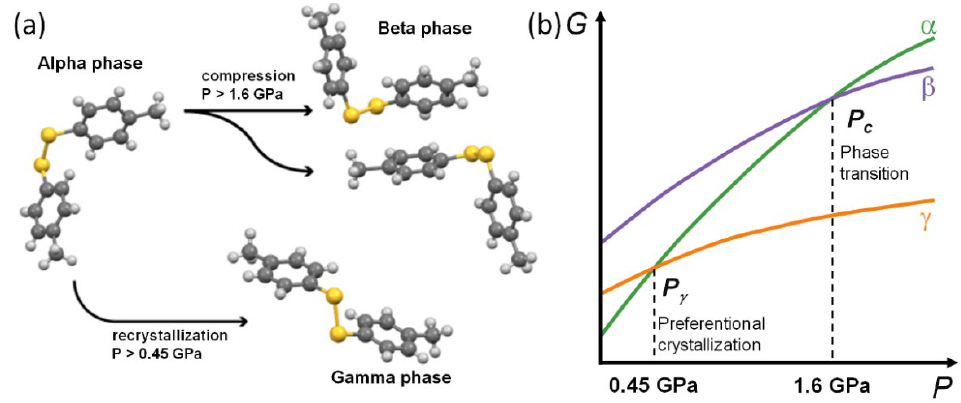
Figure 1. ( a ) Principal scheme of the experimentally observed phase transitions in a di- p -tolyl disulfide system. The α → β phase transition is given by two arrows due to formation of two different molecular conformations. ( b ) Suggested relations between the free Gibbs energy of phases α, β, and γ as a function of pressure based on experimental study (adapted from [18]).